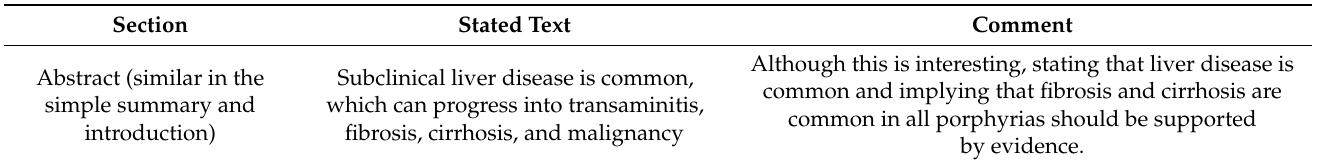
Table 1. Additional comments on specific statements in the